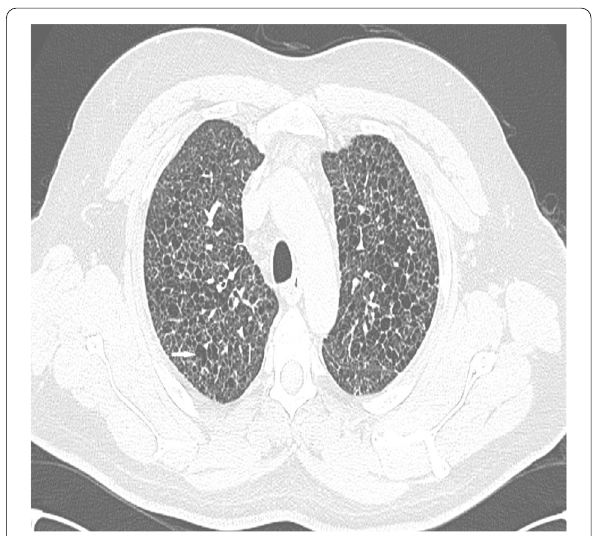
Fig. 2 HRCT of the chest, axial image, revealing variable-sized cysts with thin and thick walls, bizarre shapes (white arrow) in upper lobes